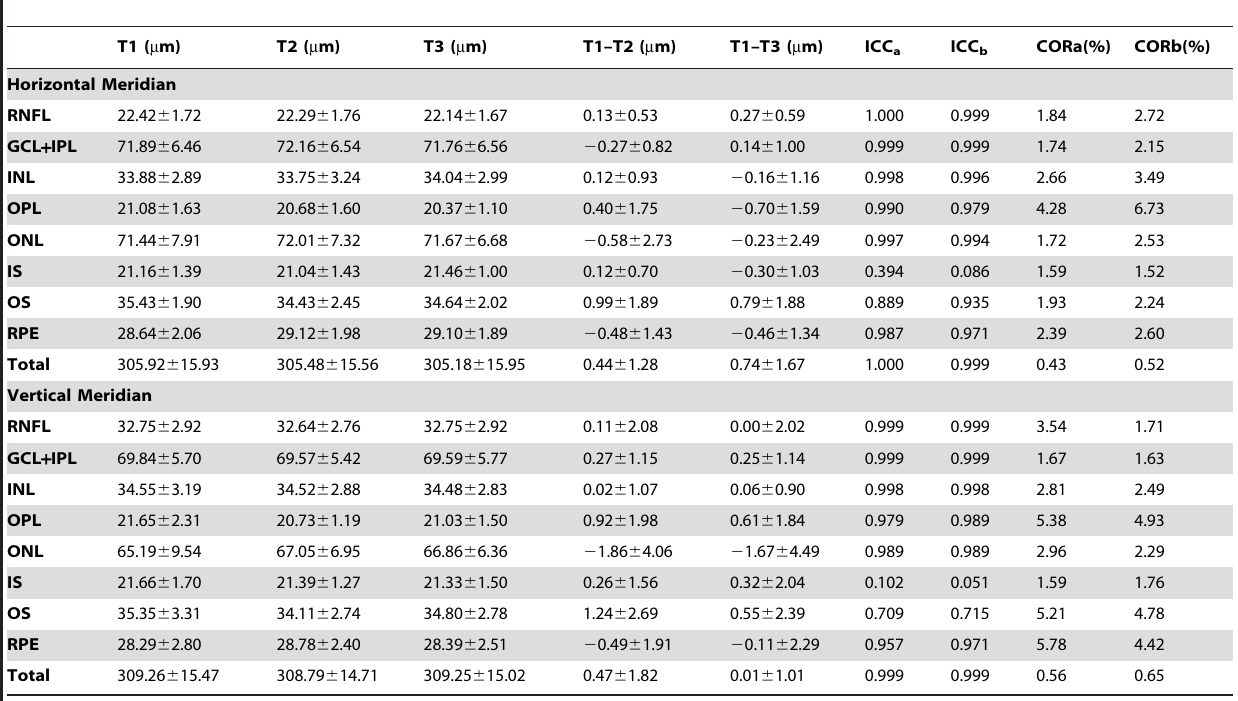
Table 3. Repeatability and reproducibility of thickness measurements for eight intra-retinal layers measured by the RTVue100.